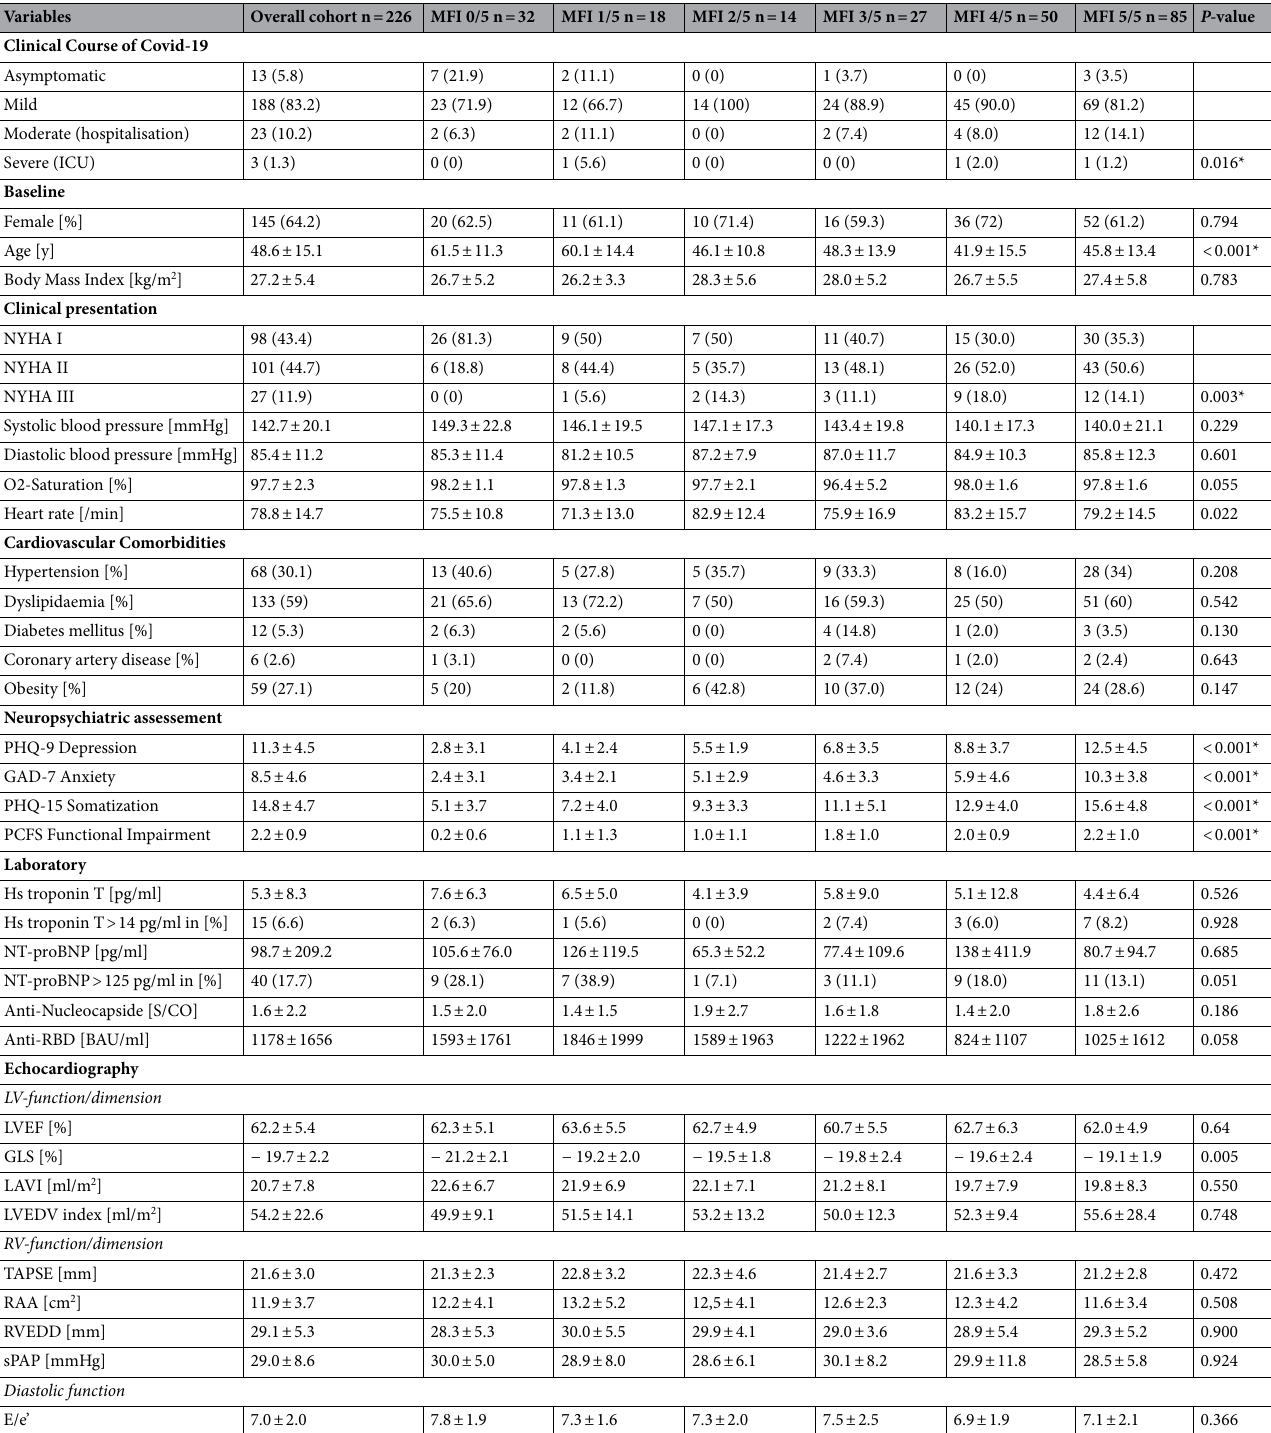
Table 2. Cardiac characteristics and multidimensional fatigue inventory. Continuous variables are presented as mean ± standard deviation, and categorical variables are presented as absolute numbers and